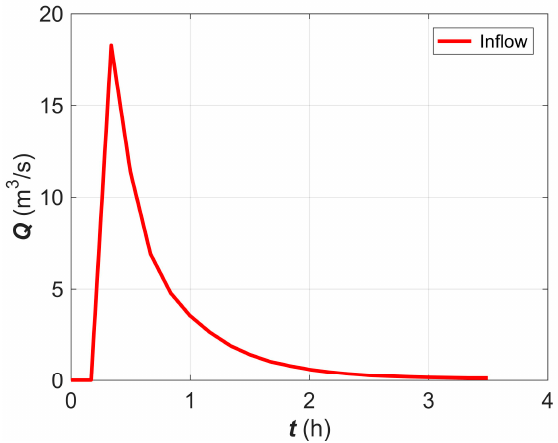
Figure 10. Inflow hydrograph.